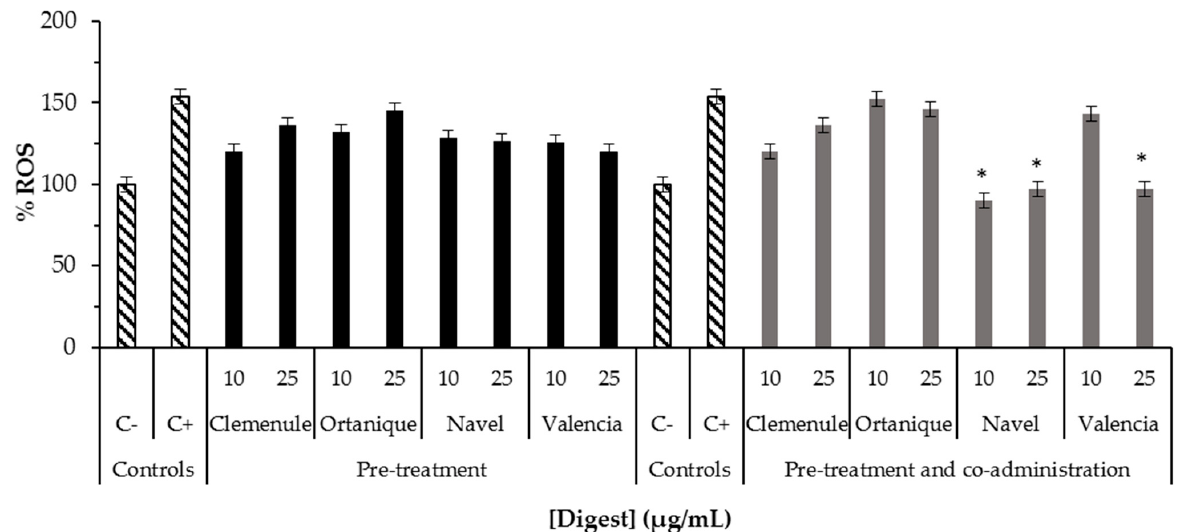
Figure 3. Induced ROS formation in normal human intestinal cells (CCD-18Co) treated with digests of Clemenule and Ortanique mandarin and Navel and Valencia orange pomaces prior to oxidative damage. Cells treated with tert-butyl hydroperoxide were used as positive control (C+), while untreated cells were employed as negative control (C − ). The formation of ROS in the negative control, fixed as the 100% basal production, was significantly increased due to the treatment with tert-butyl hydroperoxide until about 150% (C+). Pre-treatment assay: normal human colon cells were treated with samples for 24 h followed by administration of the oxidative agent (tert-butyl hydroperoxide) for 30 min. Pre-treatment and co-administration assay: cells were treated with samples for 24 h followed by co-administration of the oxidative agent (tert-butyl hydroperoxide) and sample for 30 min. Bars represent mean values while error bars denote standard error of the mean (SEM). * Indicates statistical differences between mean values with p < 0.05 by Tukey test when compared to the positive control (C+).